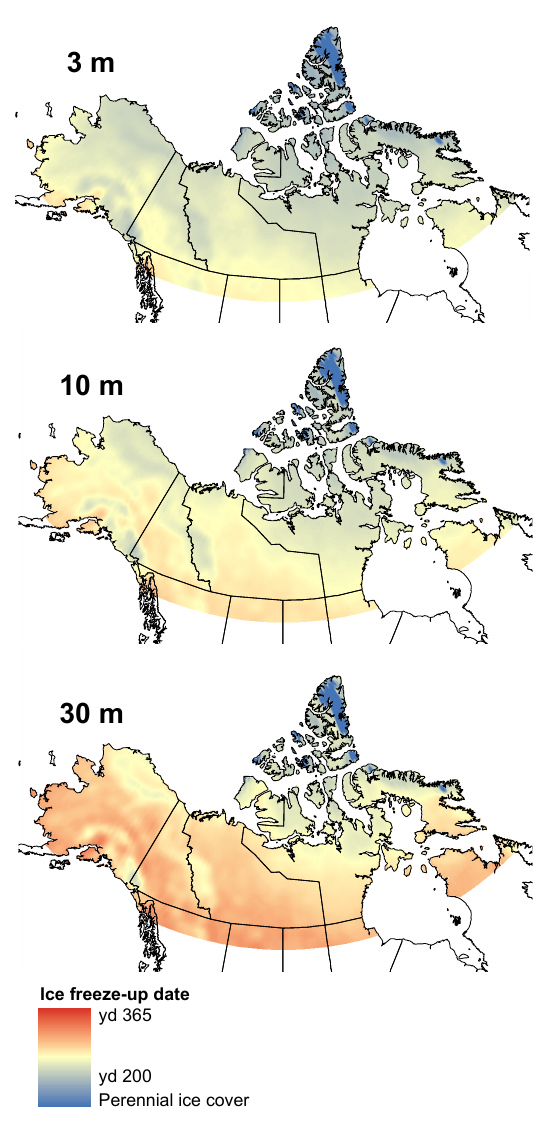
Fig. 5. Mean freeze-up dates for 1961–1990 for the three depth simulations, highlighting the effect of depth on freeze-up